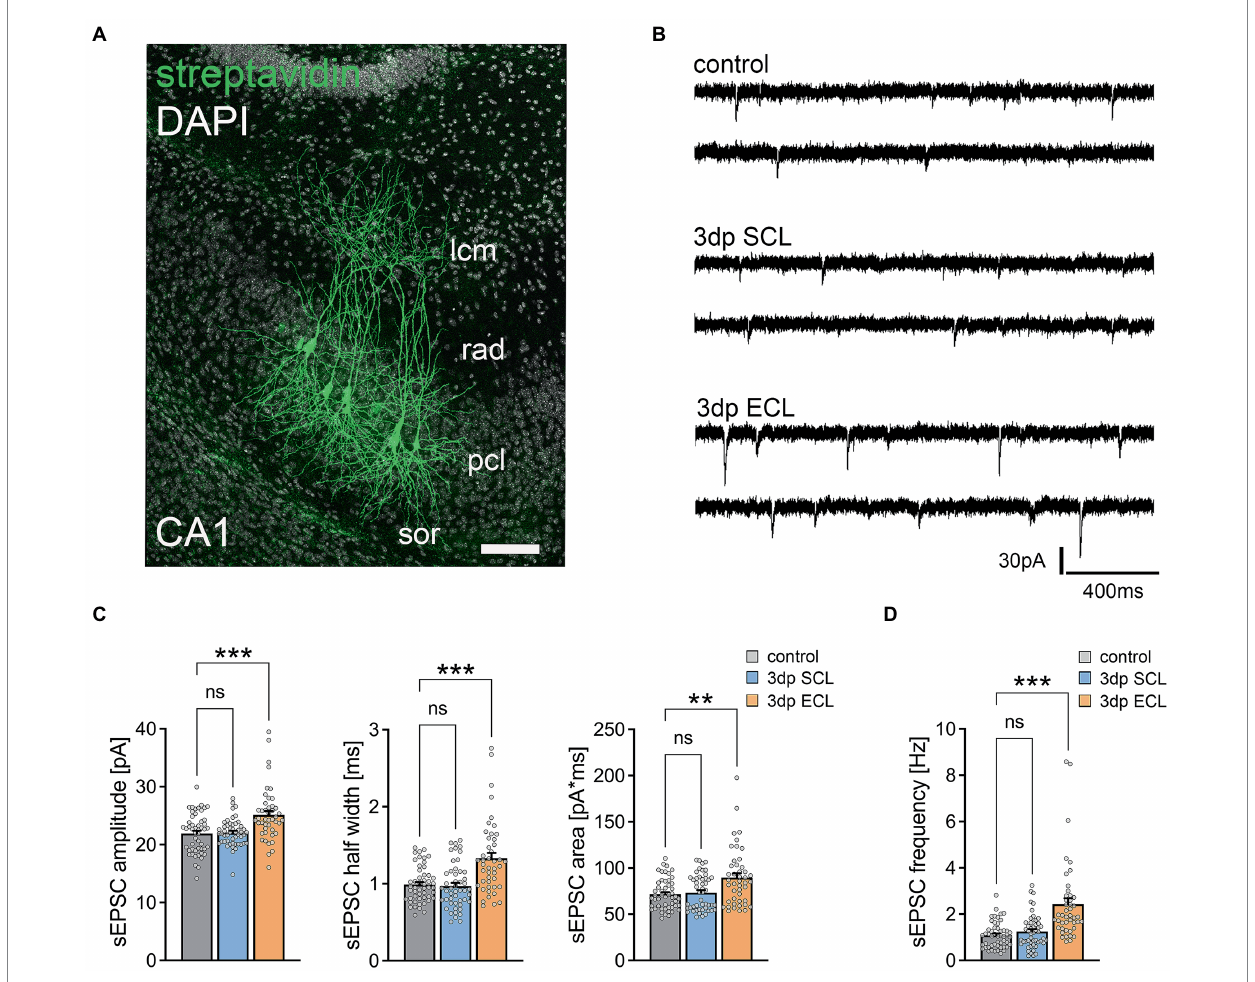
FIGURE 5 ECL but not SCL induces homeostatic synaptic plasticity in CA1 pyramidal neurons. (A) Posthoc visualization of CA1 pyramidal neurons after electrophysiological assessment (sor, str. oriens; pcl, str. pyramidale; rad, str. radiatum; lcm, str. lacunosum-moleculare). Scale bar, 100 μ m. (B) Sample traces of spontaneous excitatory postsynaptic currents (sEPSC) recorded in hippocampal CA1 cells in non-lesioned control cultures as well as 3 days after either SCL or ECL (3dp, 3 days post lesion). (C,D) While sEPSC amplitude, half width and area as well as sEPSC frequency (D) were significantly increased in CA1 pyramidal neurons 3 days after ECL, no such effects can be observed following SCL (n control = 51 cells in 14 cultures, n SCL = 49 cells in 13 cultures, n ECL = 45 cells in 12 cultures, Kruskal-Wallis test followed by Dunn’s posthoc correction). Individual data points are indicated by colored dots. Values represent mean ± s.e.m. (** p < 0.01, *** p < 0.001, ns - non significant